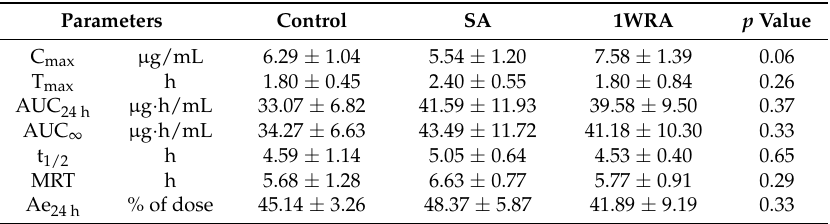
Data were expressed as mean ± SD from five rats of control, SA, and 1WRA groups, respectively. p value indicates static comparison among three groups using one-way ANOVA test. C max : maximum plasma concentration; T max : time to reach C max . AUC 24 h or AUC ∞ : Area under plasma concentration– time curve from zero to 24 h or infinity. t 1/2 : elimination half-life; MRT: mean residence time. Ae 24 h : the fraction of the dose excreted in urine for 24 h as a parent form.